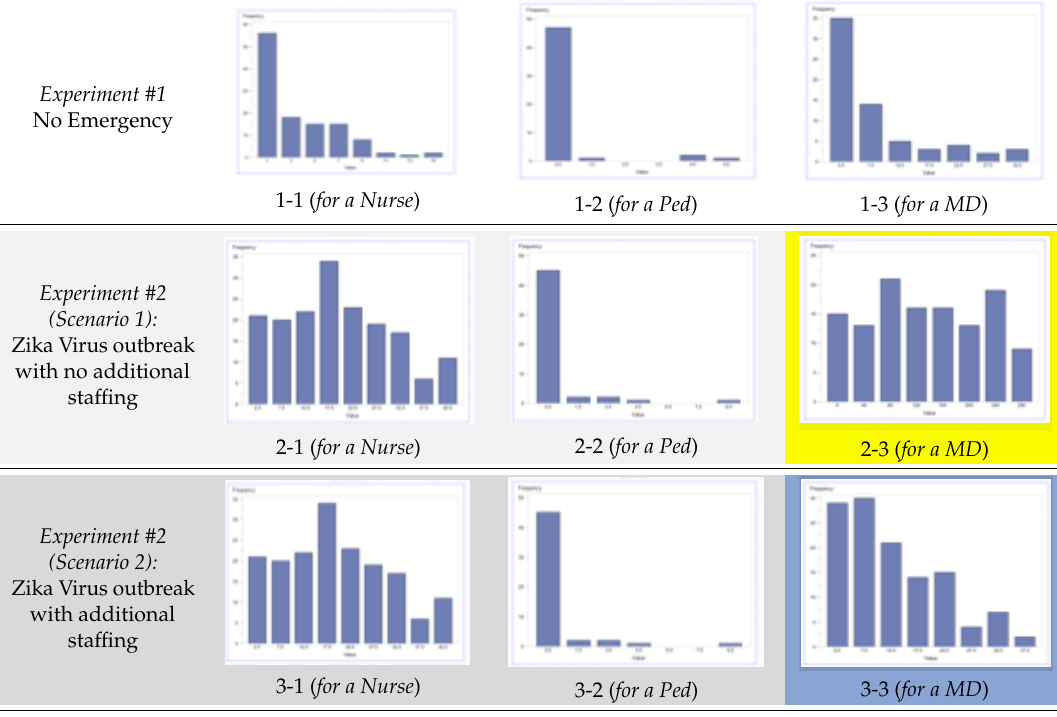
Table 4. Histograms of waiting time for patients during one day for each experiment.